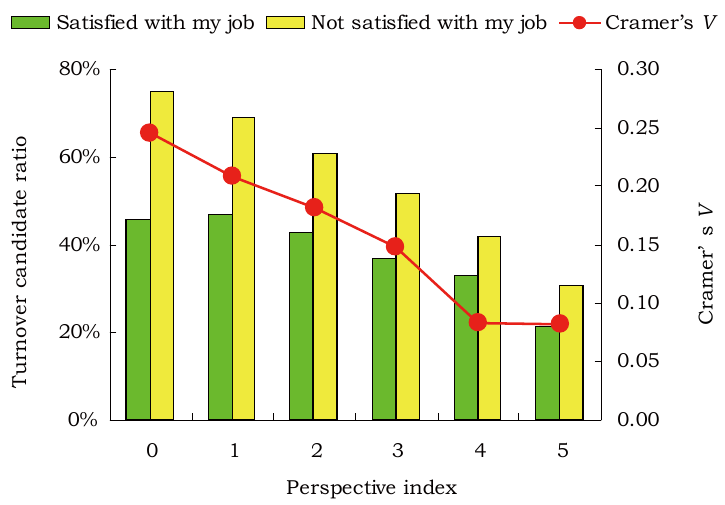
Figure 3. Correlation coefficient for turnover candidate ratio per perspective index/job satisfaction (JPC Survey,